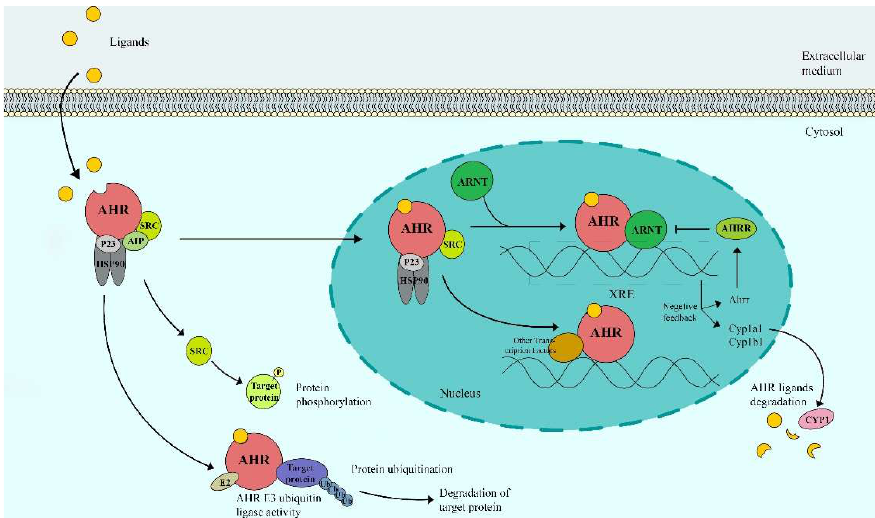
Figure 1. The cellular Aryl hydrocarbon receptor (AHR) signaling pathway. Once the different agonists bind to the AHR receptor, conformational changes in the complex appeared, leading to the activation of AHR, nuclear translocation, and a series of the downstream gene expression, which plays an important role in the inflammation-related diseases. Abbreviations: HSP90,90 kDa heat shock protein; AIP, AHR-interacting protein; ARNT, AHR nuclear translocator; XREs, xenobiotic response elements; AHRR, aryl hydrocarbon receptor repressor; CYP, Cytochrome